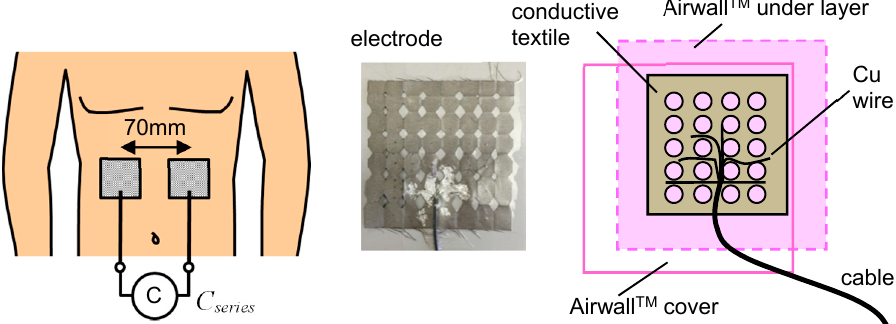
Figure 2. Typical electrodes attached to the skin; conductive textiles are used.